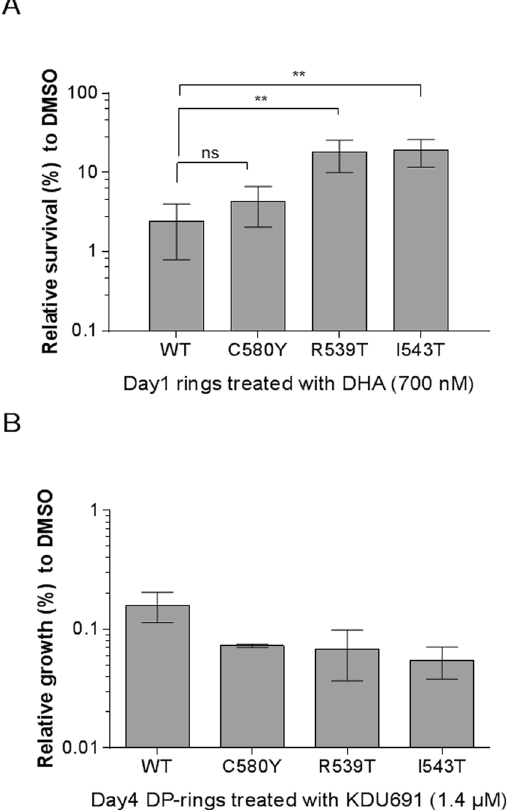
Figure 4. K13-mediated ART resistance is associated with a higher proportion of DP-rings. ( A ) Prevalence of viable DP-rings detected in K13 mutant Dd2 transgenic and Dd2-WT parasites following six hours of exposure to 700 nM DHA. Growth was measured at day one and survival normalized to DMSO-treated control parasites. ( B ) DP-rings susceptibility in K13 mutant Dd2 transgenic and Dd2-WT parasites exposed to KDU691 (1.4 µ M) and measured at day four. Data are from three biological experiments and three technical replicates each (means ± SEM % growth). Percent growth was measured by HCI using MitoTracker ® Orange relative to